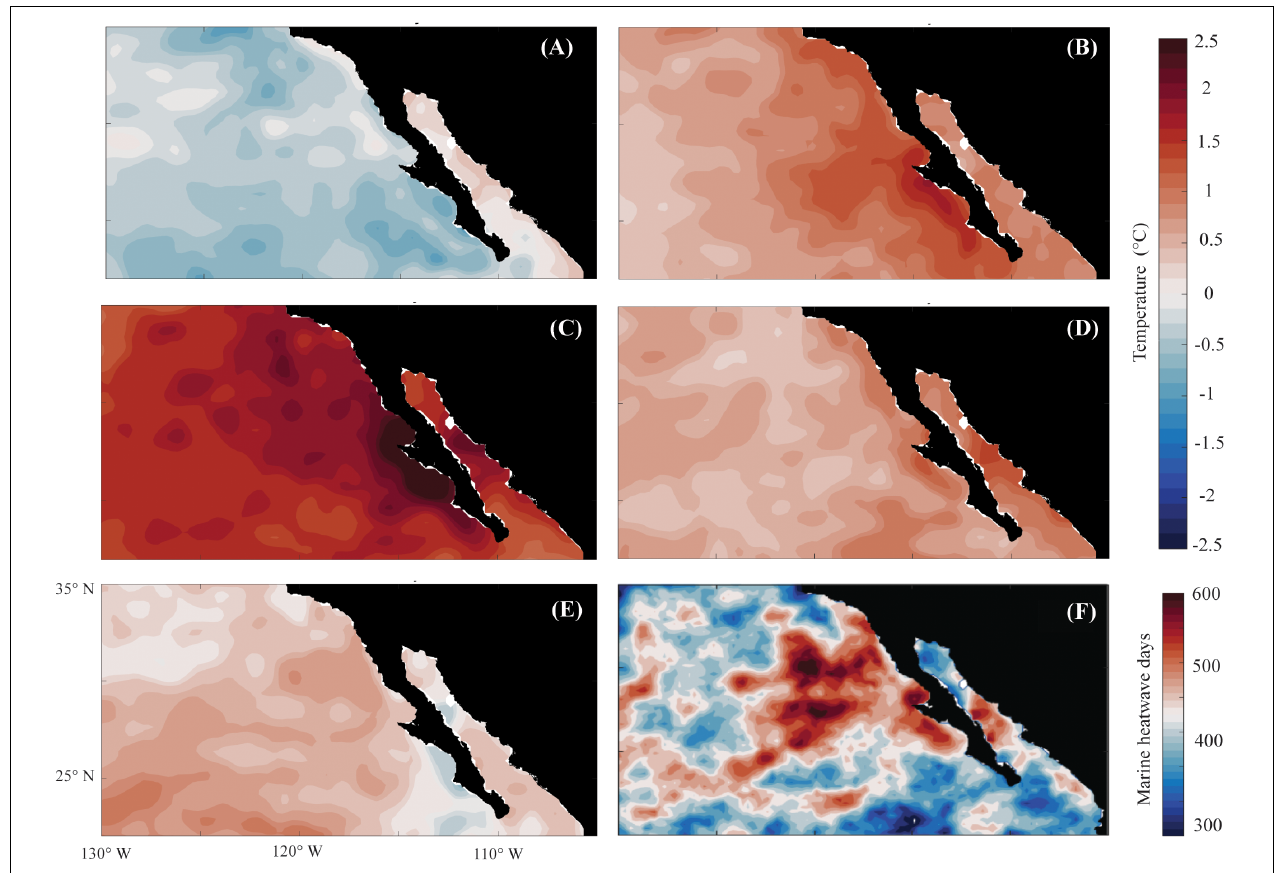
FIGURE 2 | Mean low-pass sea surface temperature anomalies ( ◦ C) for (A) 2013, (B) 2014, (C) 2015, (D) 2016, (E) 2017, at Baja California, Mexico. (F) Total number of marine heatwave days [ sensu Hobday et al. (2016)] detected for 2014–2017 period in Baja California.